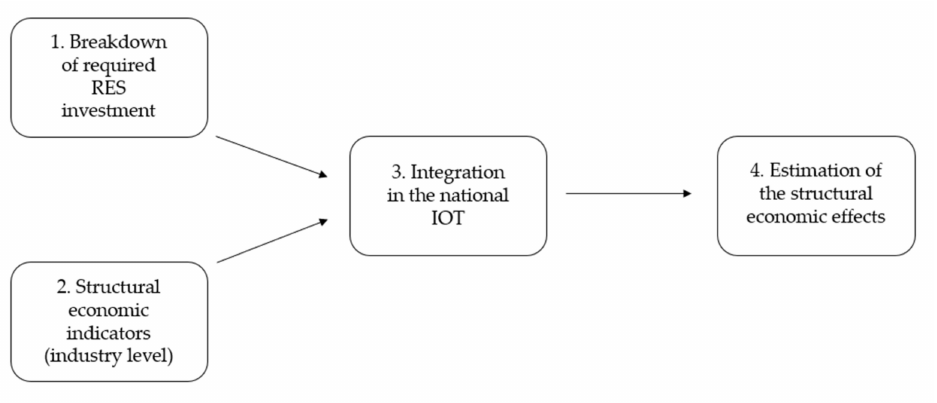
Figure 1. A simplified overview of the methodological